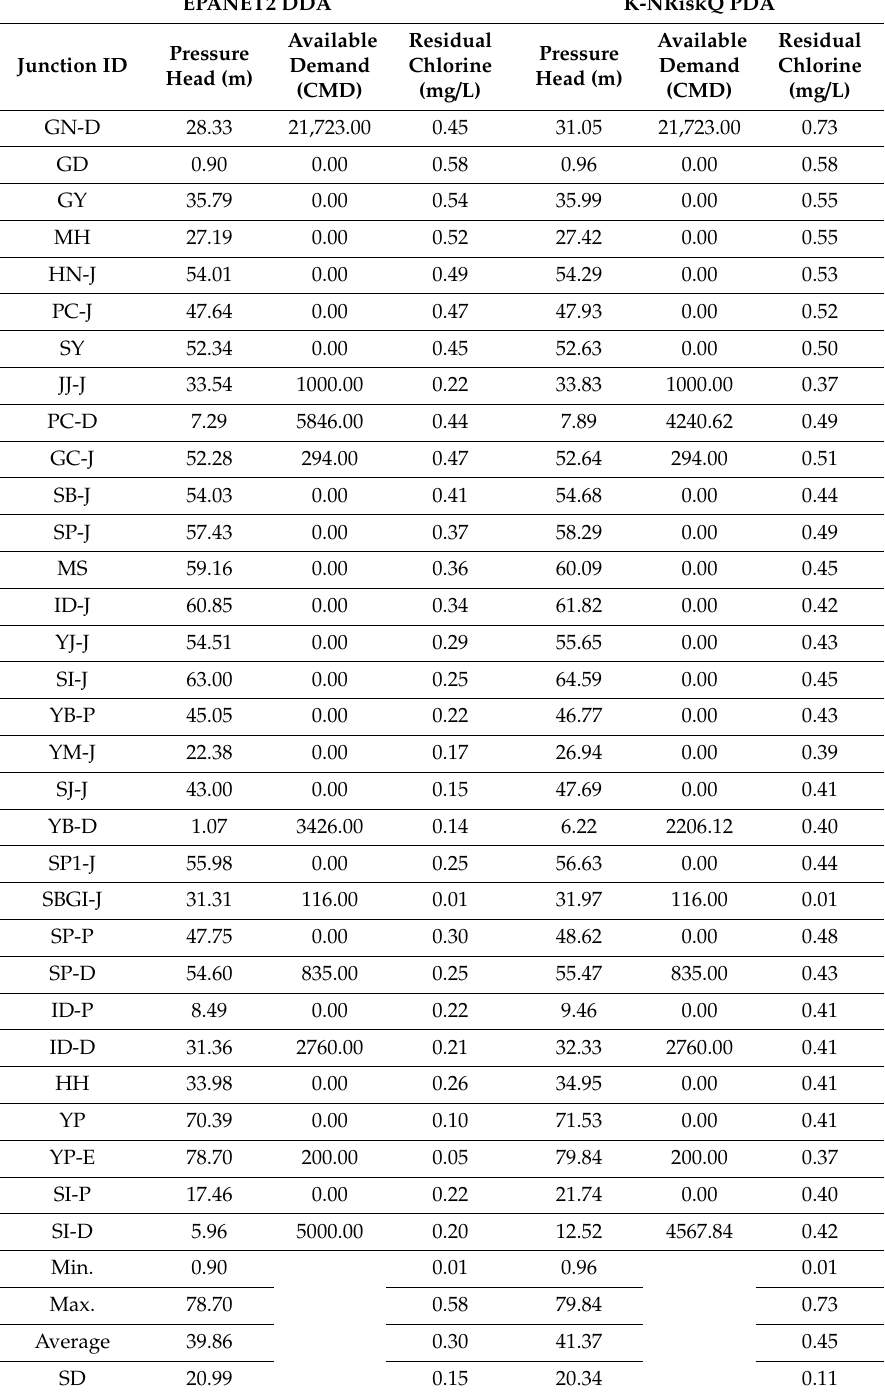
Table 3. Hydraulic and water quality results under abnormal